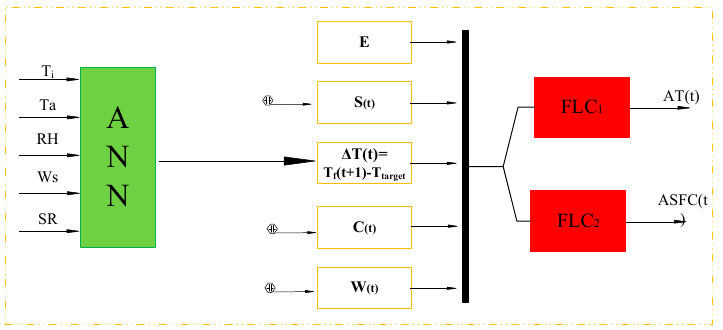
Figure 2. Parallel control fuzzy scheme (PCFS).